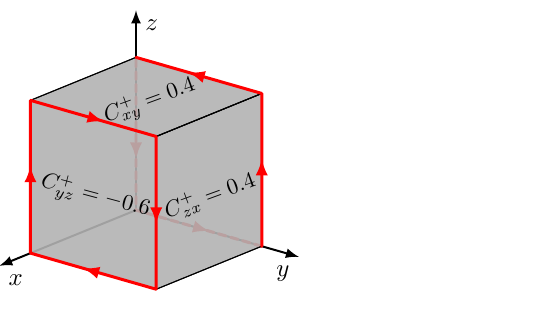
Figure 10: The Majorana zero modes of the model Hamiltonian in Eq. (84). The surface Chern numbers C ± are as defined in Eq. ij